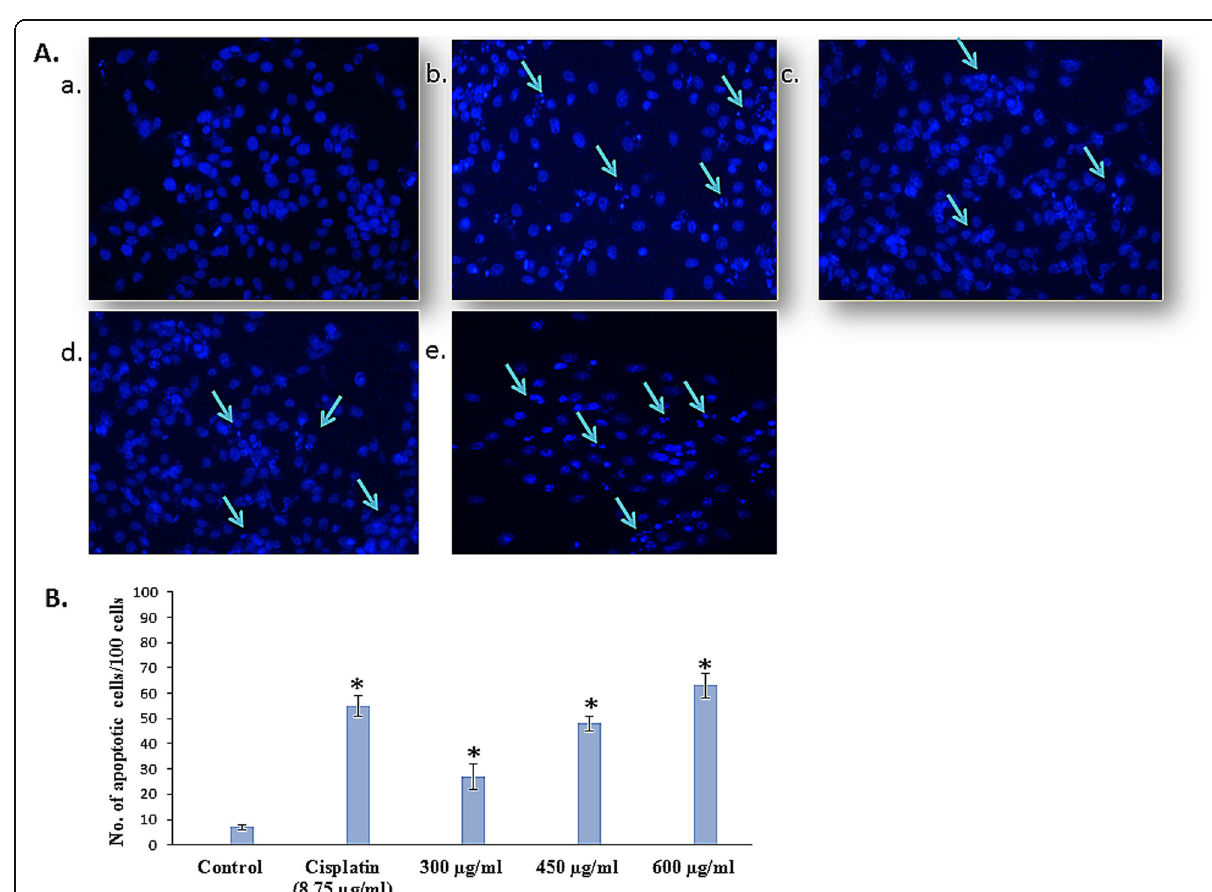
Fig. 3 a Representative fluorescence images of DAPI staining showing apoptotic nuclei in treated cells. A549 human lung cancer cells were treated with cisplatin (IC 50 concentration) and different concentrations of MEUP (300 μ g/ml, 450 μ g/ml, 600 μ g/ml). (a) Control, (b) cisplatin (8.75 μ g/ml), (c) MEUP (300 μ g/ml), (d) MEUP (450 μ g/ml), (e) MEUP (600 μ g/ml). Morphological changes are indicated by arrows. b Number of apoptotic cells/100 cells increased with increase in concentration of MEUP. Results are expressed as mean ± SD. The asterisk represents a significant difference in cell deaths between control and treatment groups. ( P <